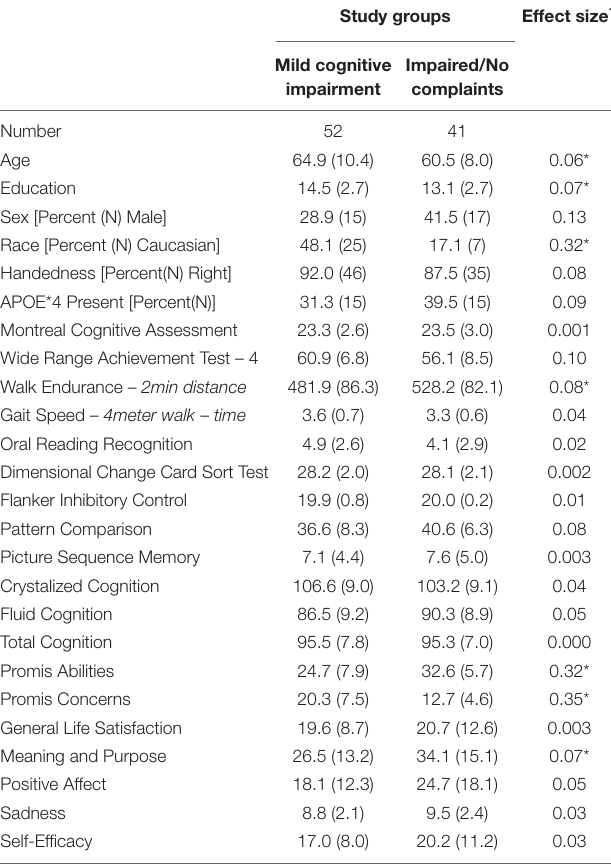
TABLE 3 | Characteristics of cognitively impaired participants by